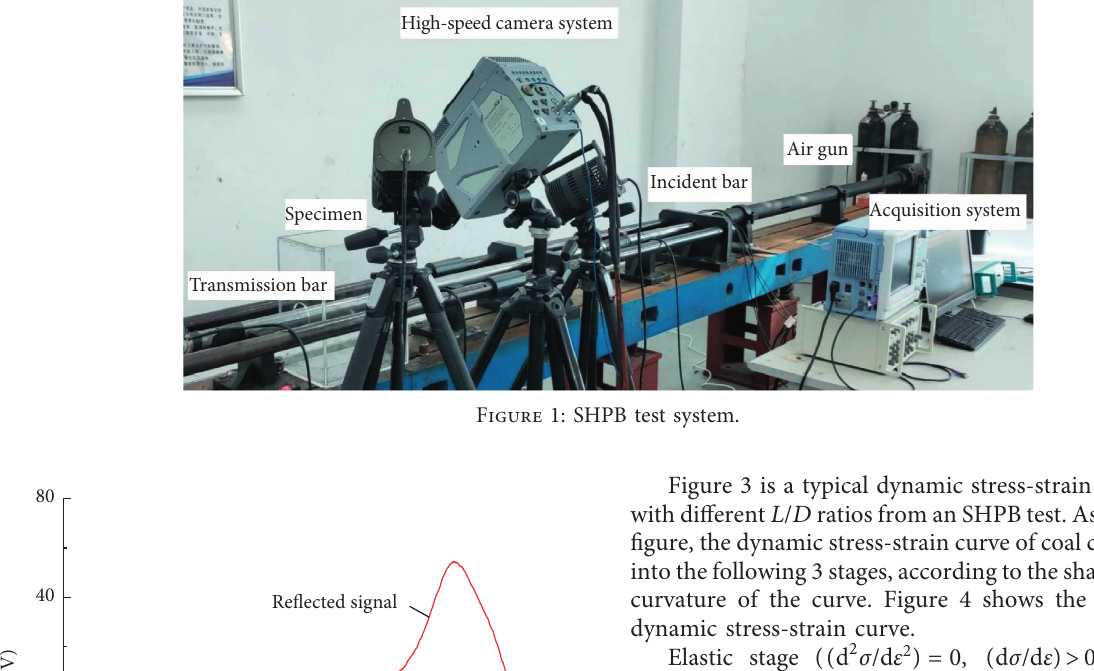
Figure 4): the stress-strain curve rises linearly at this stage.